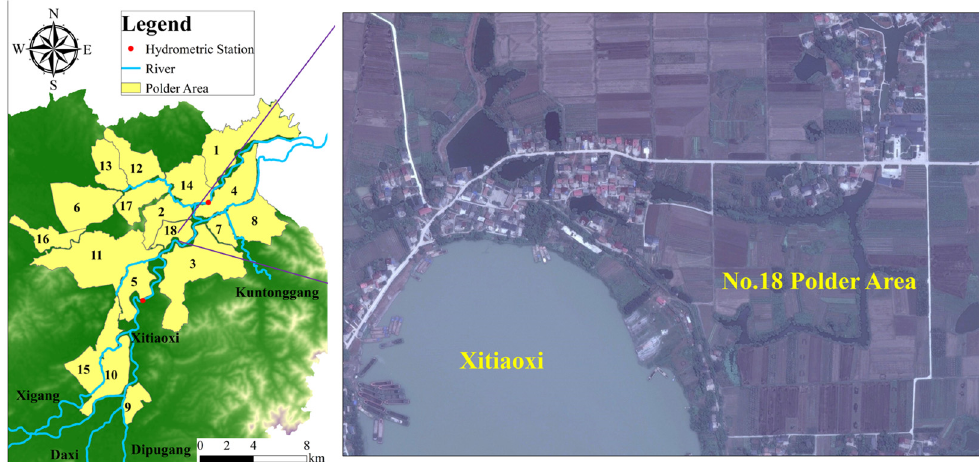
Figure 2. Location of polder areas.